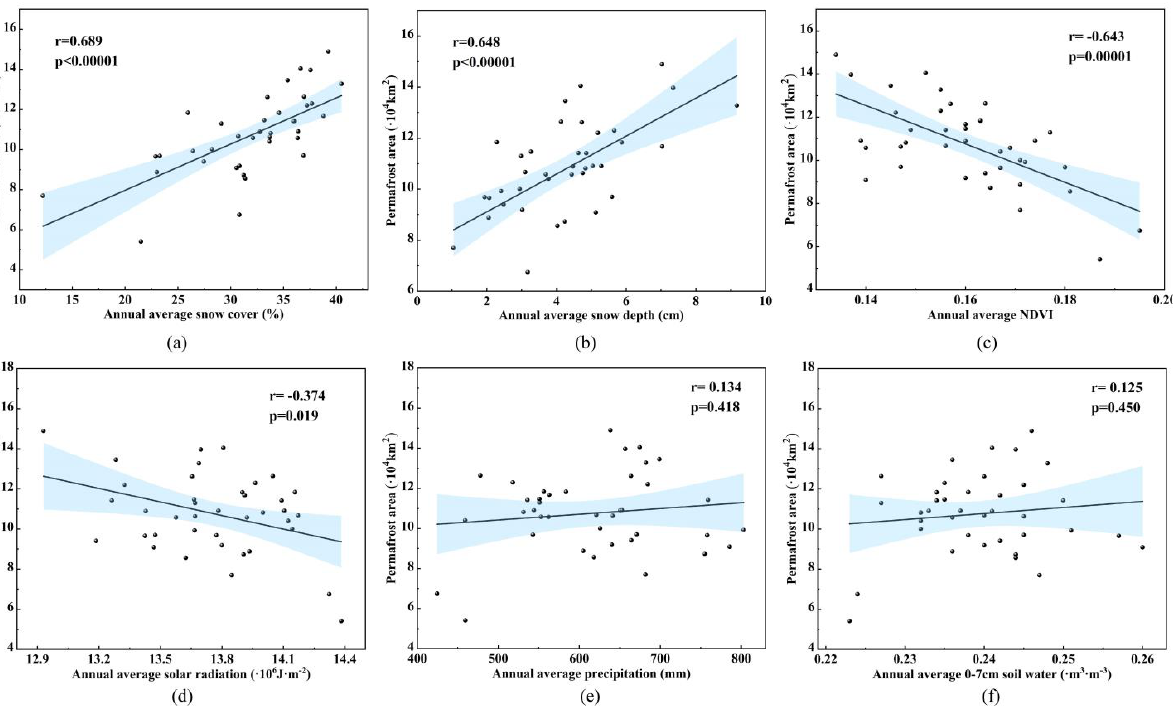
Figure 8. Pearson correlation coefficients: ( a ) permafrost and annual average snow cover; ( b ) per- mafrost and annual average snow depth; ( c ) permafrost and annual average NDVI; ( d ) permafrost and annual average solar radiation; ( e ) permafrost and annual average precipitation; ( f ) permafrost and annual average 0 – 7 cm soil water content.